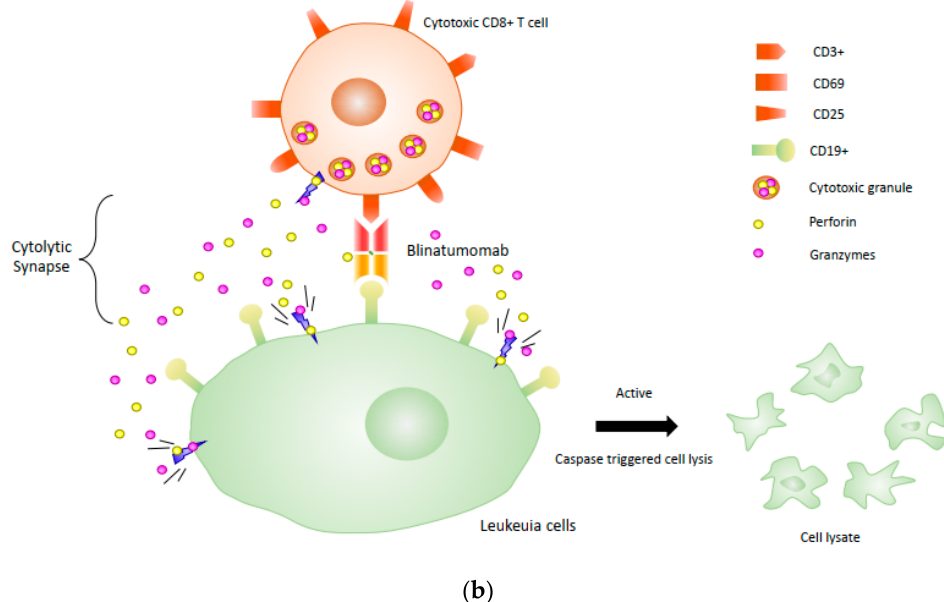
Figure 2. ( a ) The construction of three main bispecific antibody fragment molecules. ( b ) The mechanism of Blinatumomab treatment. Blinatumomab as a bispecific antibody can simultaneously bind to CD3+ T-cells and CD19+ leukemia cells and has been approved for the treatment of B-cell precursor acute lymphoblastic leukemia (ALL).